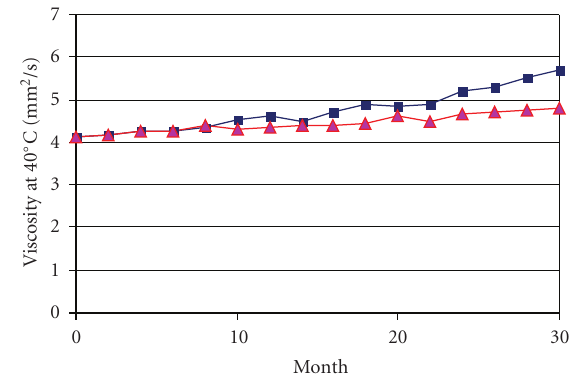
Figure 8: Variation in the kinematic viscosity of corn oil biodiesel stored (cid:2) under normal oxygen atmosphere and (cid:3) under argon